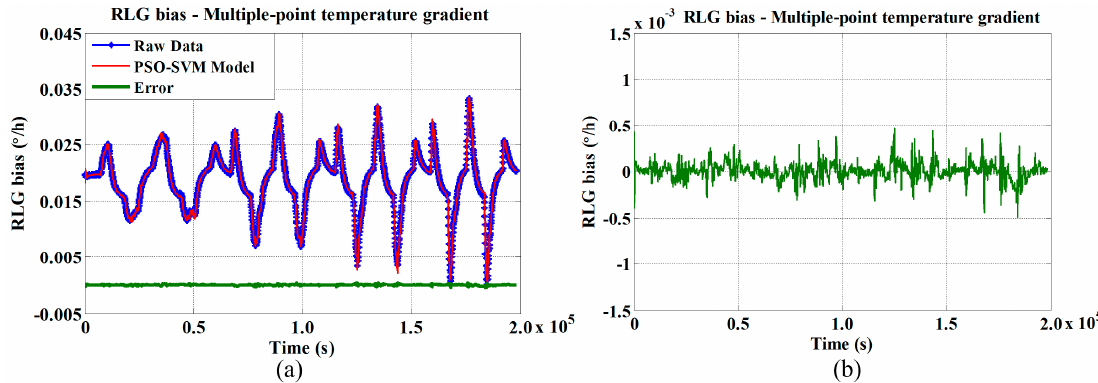
Figure 6. RLG bias compensation model utilizing traditional three-point temperature gradient algorithm at ( a ) different temperature variation rates, and ( b ) enlarged error curve.